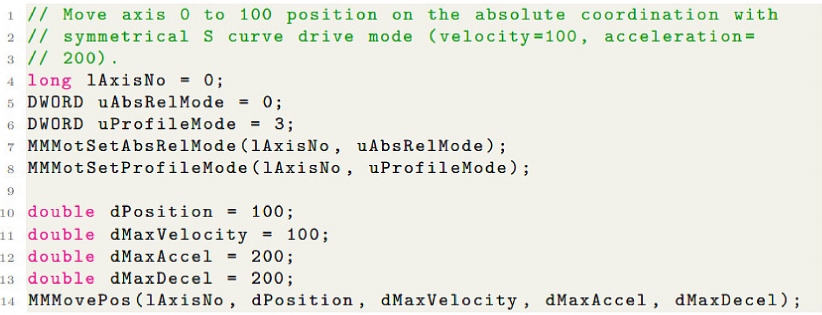
Figure 15. Code listing for one axis movement.